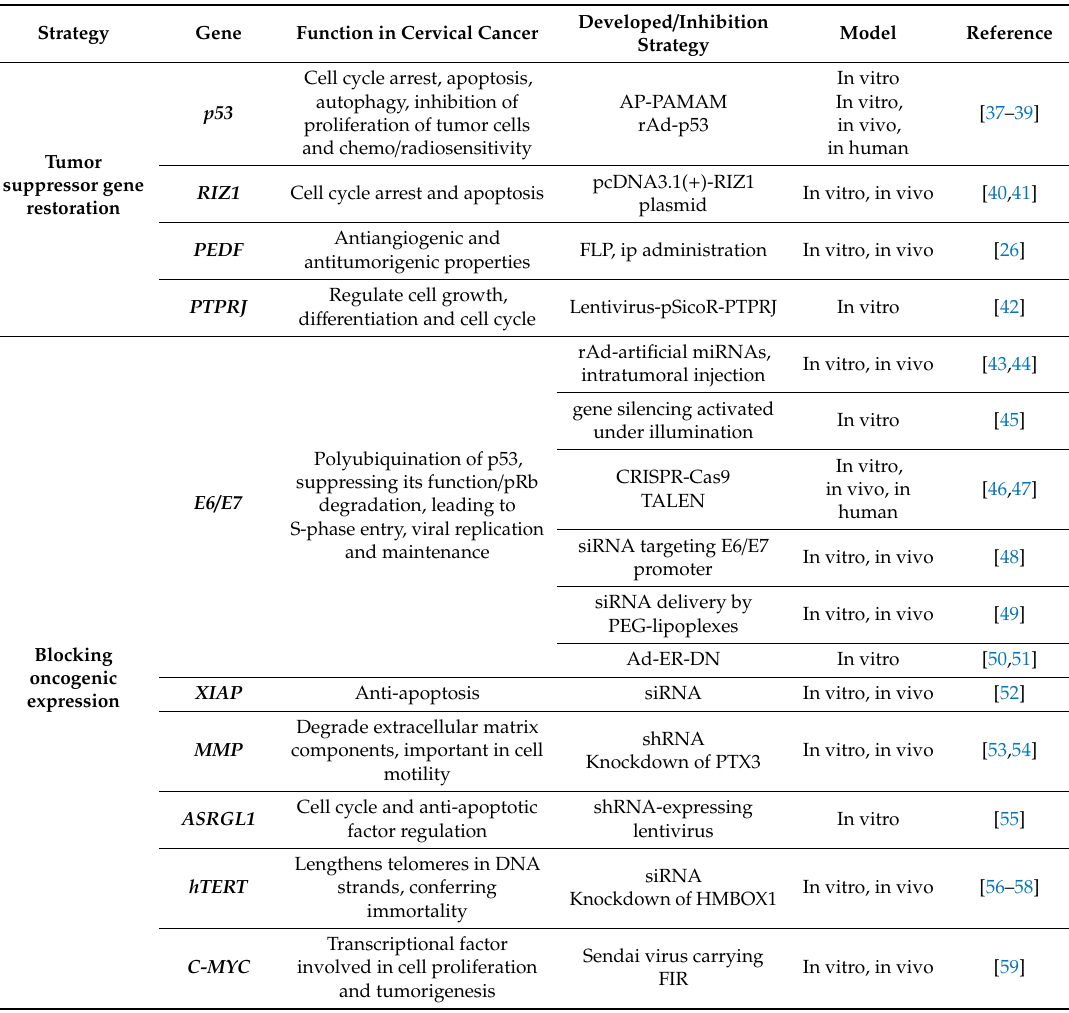
Table 1. Most recent approaches focused on mutation compensation strategy for cervical